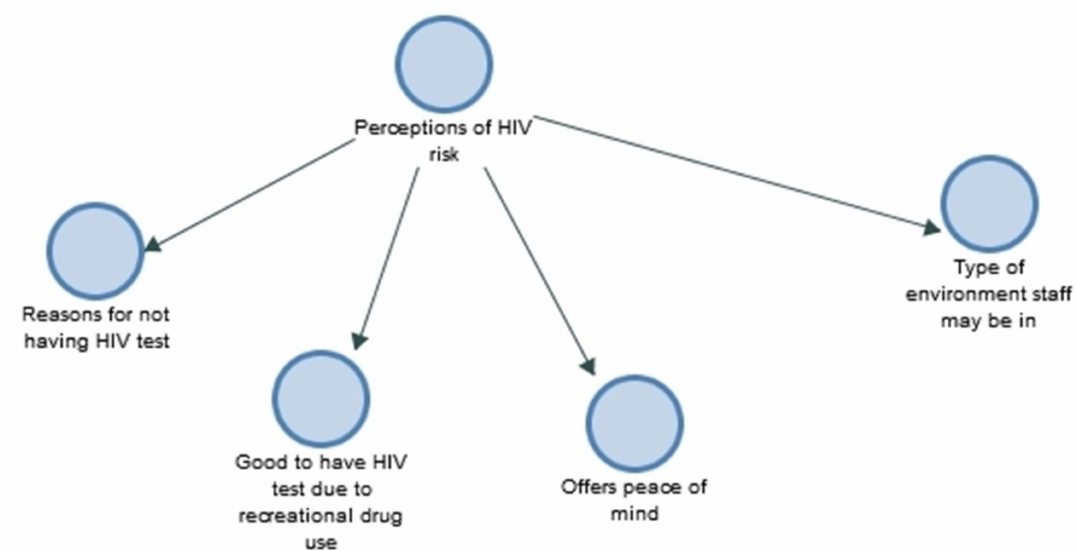
Figure 2. Theme (b): Perceptions of HIV